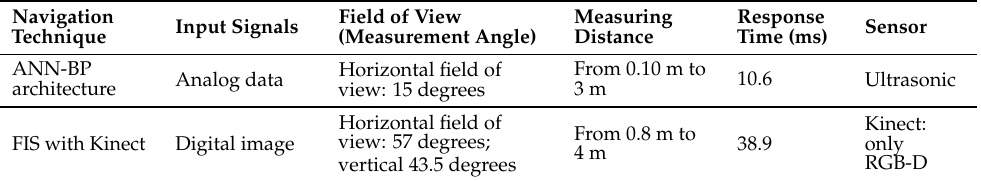
Table 4. Environmental input data.